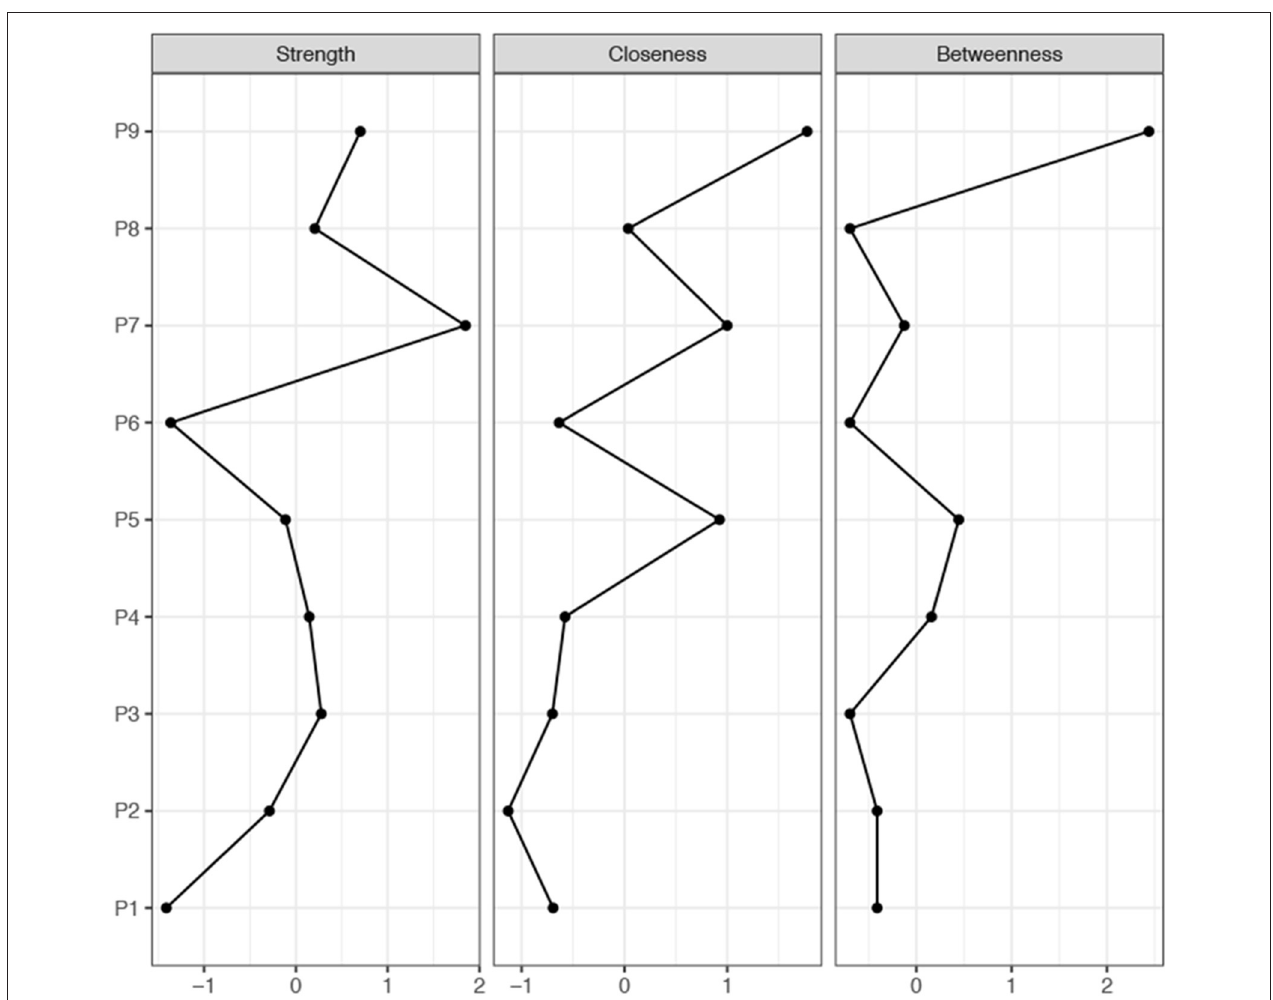
FIGURE 2 | The strength, closeness, and betweenness of the “Cor” network of